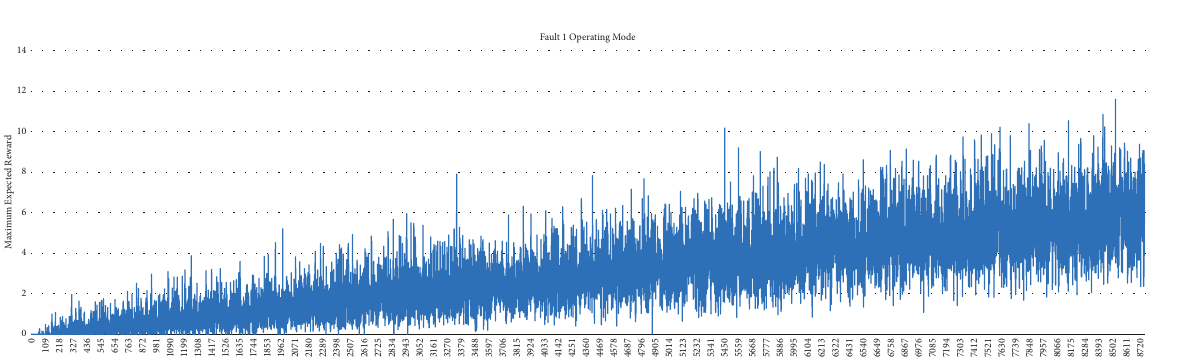
Figure 9: Maximum reward obtained for the Fault 1 operation mode of the IPR in one year of operation.